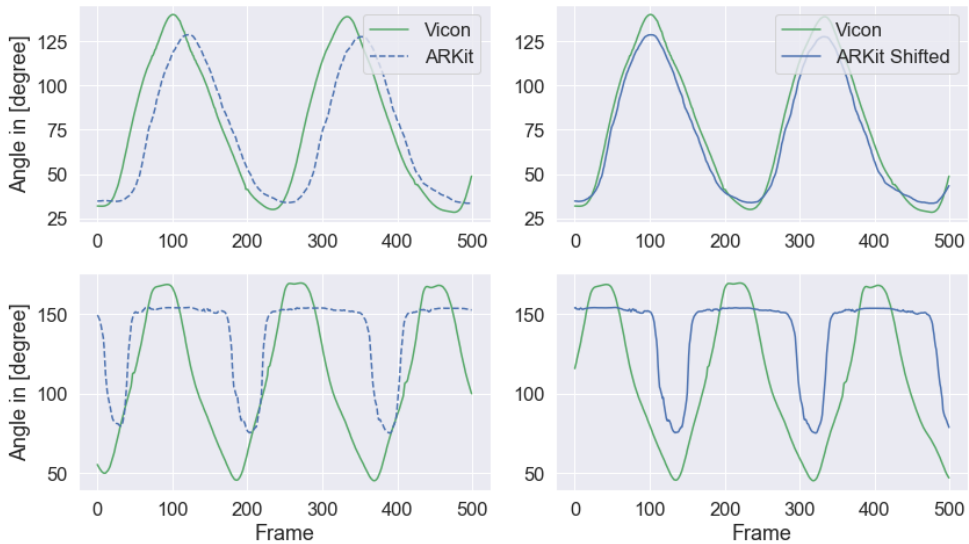
Figure 3. Shift of the data.